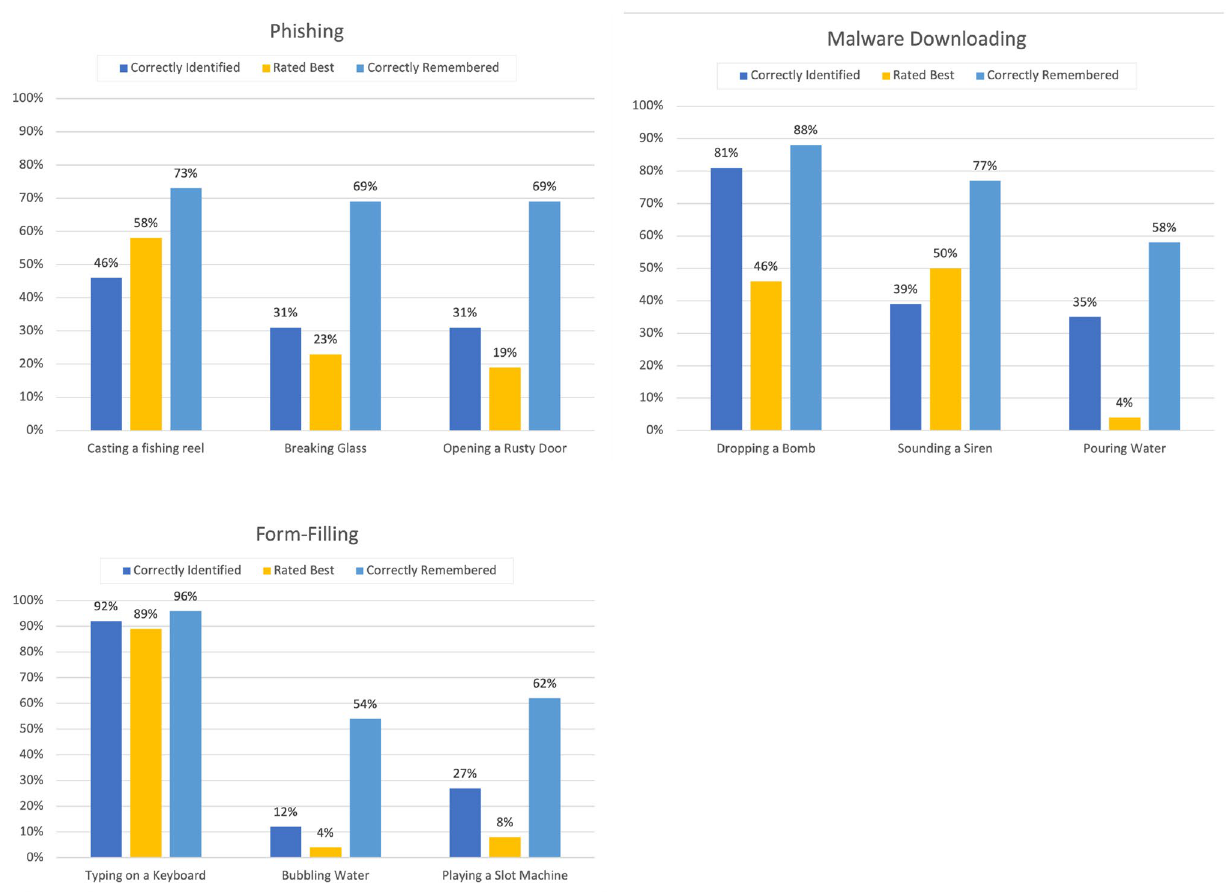
Fig. 4 The Out-of-Context formative evaluation for users who are not visually